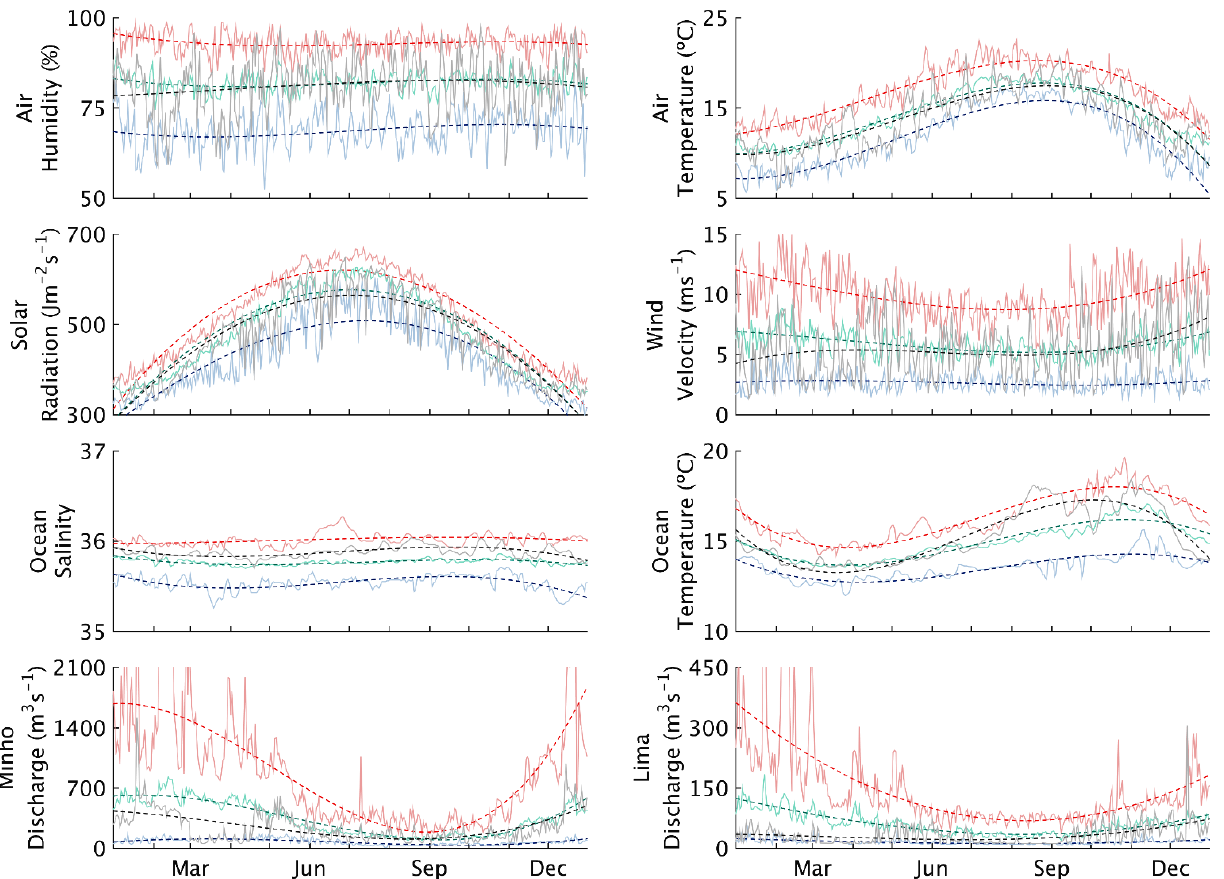
Figure 2. Annual variation of the air humidity and temperature, solar radiation, wind velocity, ocean salinity and temperature, and Minho and Lima discharges. The red, green and blue solid lines represent the maximum, average and minimum daily values for the period 2010 – 2020, respectively. The grey solid line represents the years 2012 – 2013. The dashed lines characterize the tendency of each variable.